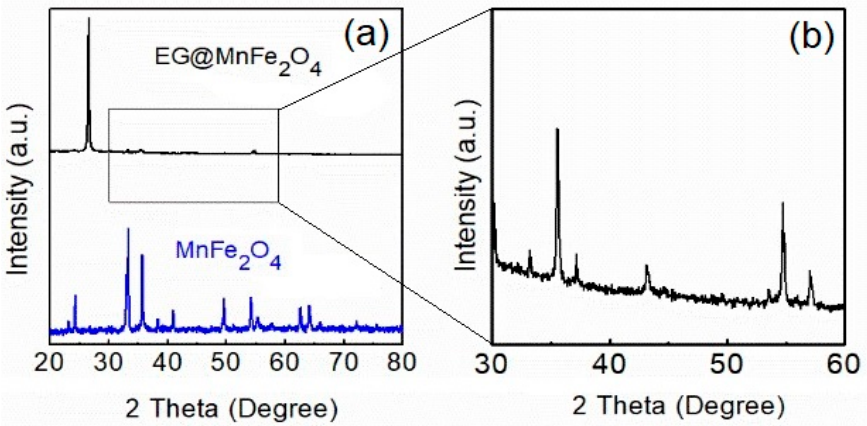
Figure 2. XRD di ff raction of EG@MnFe 2 O 4 ( a , b ) and MnFe 2 O 4 ( a ). Figure 2. XRD diffraction of EG@MnFe 2 O 4 ( a , b ) and MnFe 2 O 4 (a). Figure 2. XRD diffraction of EG@MnFe 2 O 4 ( a , b ) and MnFe 2 O 4 (a).